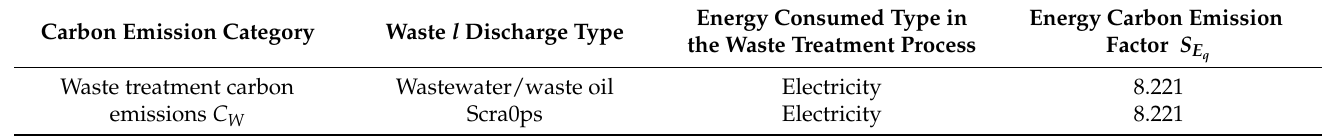
Table 7. Values of carbon emission factors for waste